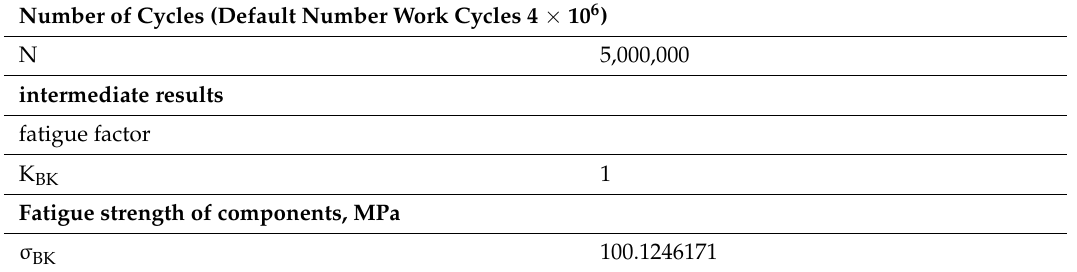
Table 14. The number of working cycles effect on the model strength.